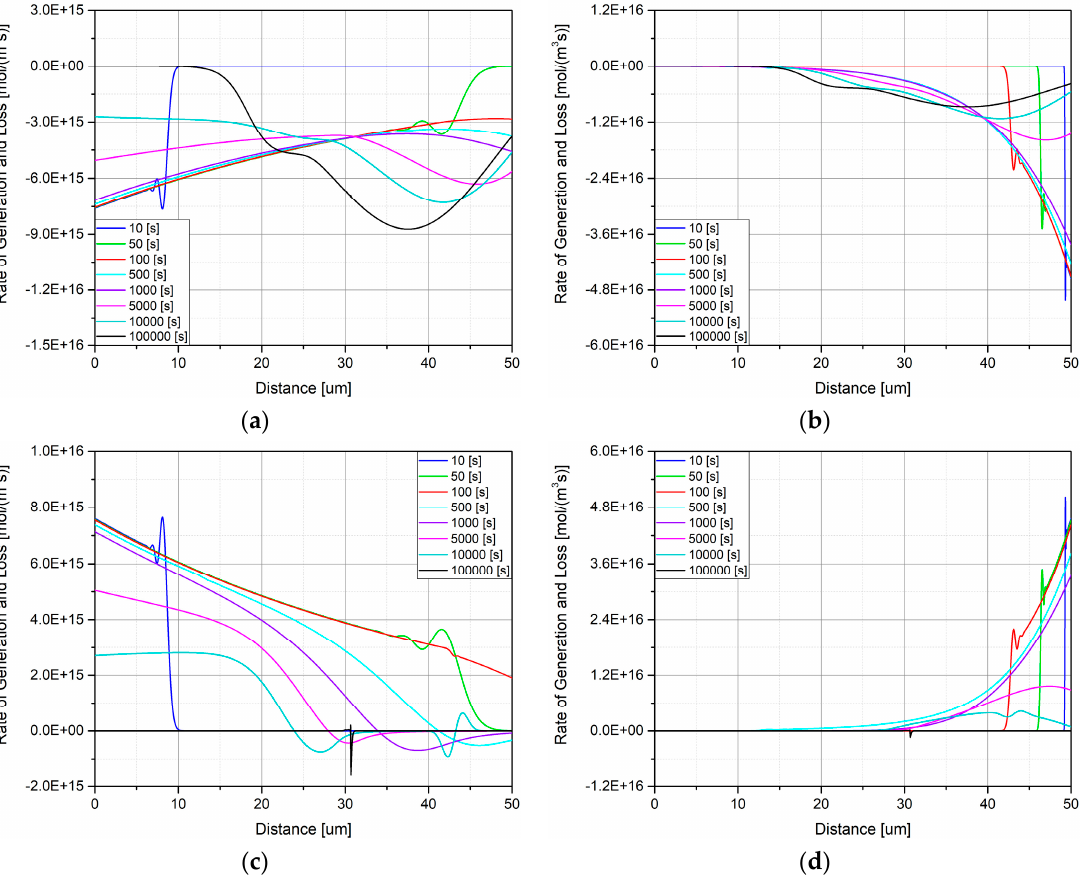
Figure 3. Rates of generation and loss of carriers at room temperature (= 20 °C): ( a ) mobile electrons; ( b ) mobile holes; ( c ) trapped electrons; ( d ) trapped holes.